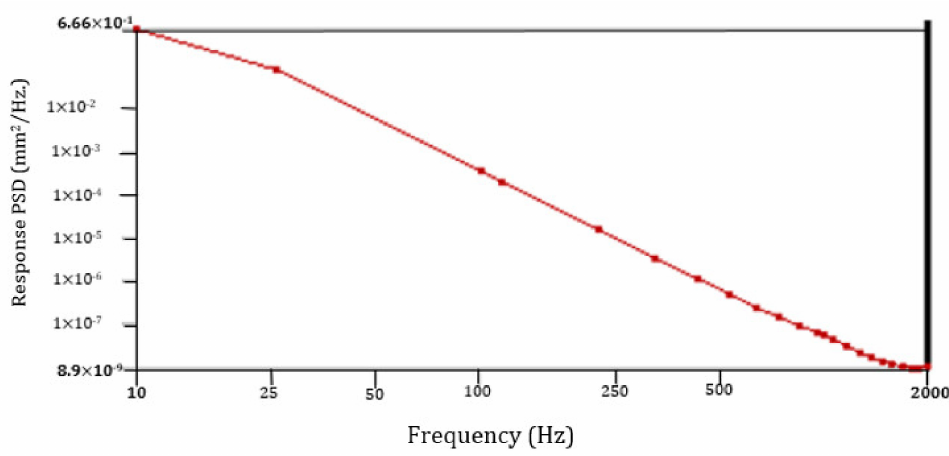
Figure 20. PSD response graph displaying peak g acceleration